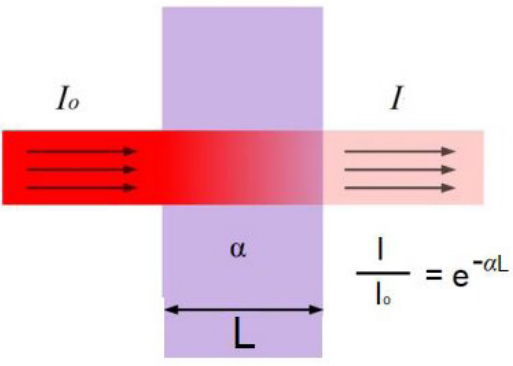
Figure 1. Beer Lambert Law. Source the